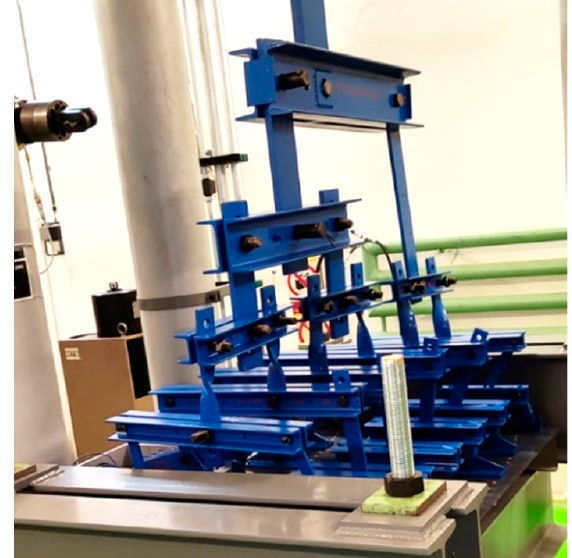
Figure 8. Whiffle tree loading